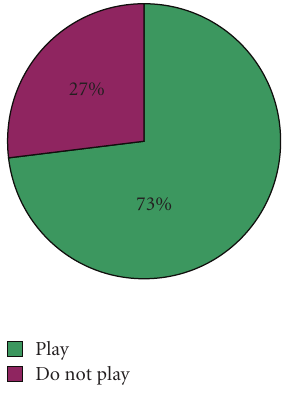
Figure 5: Percentage of players who play multiplayer